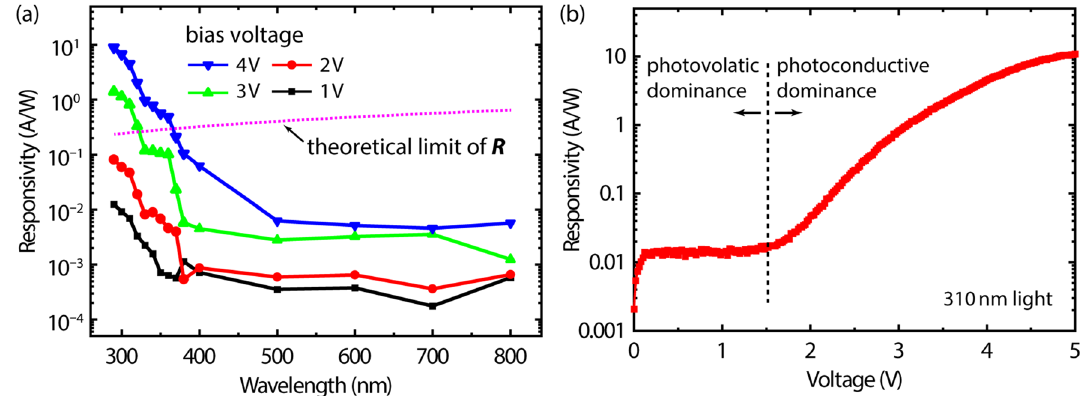
Figure 3. Photoresponse. ( a ) Spectral photoresponse of the Gr/AlGaN/GaN photodetector under various bias voltages. ( b ) Responsivity as a function of induced voltage under 310-nm illumination. Note the logarithmic scale of the responsivity